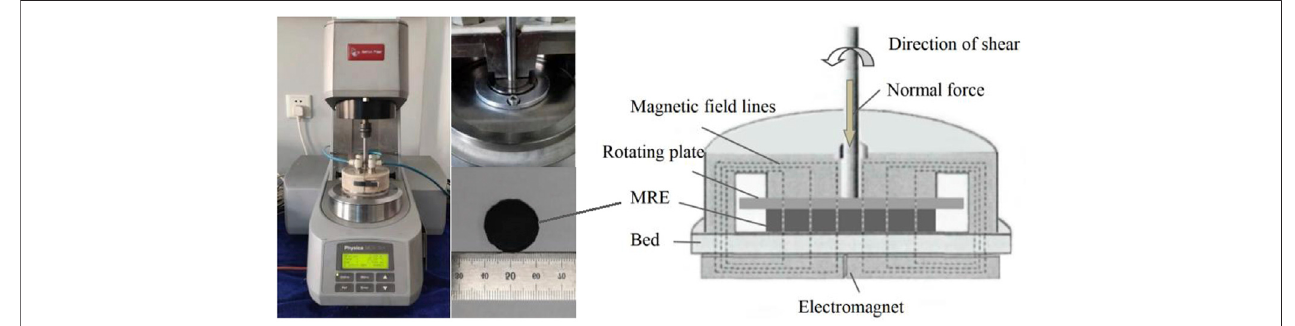
FIGURE 2 | Rotary rheometer, specimen and schematic of the measuring system.